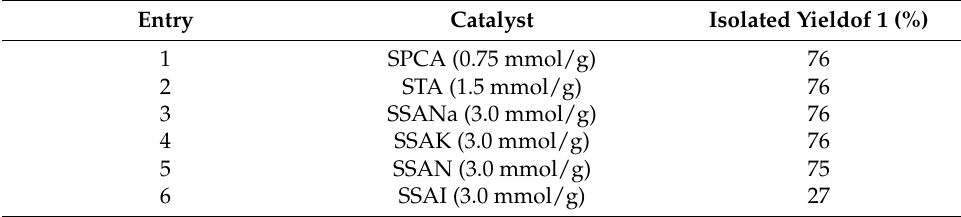
Table 2. Evaluation of different silica supported